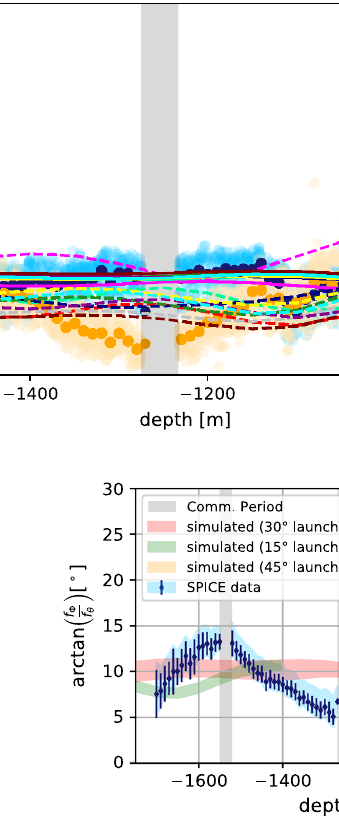
Fig. 12 Measured polarization at the ARIANNA station and the expected polarization after propagating the anechoic chamber pulses through the birefringence model. The adjacent launch angels of 15 and 45 degrees were included for comparison. The gray areas mark com- munication periods during which no data was taken. The SPICE data was averaged over 10m depths, and the 1 σ spread of the distribution is shown with the blue error bars. The light blue shading indicates the systematic uncertainty on the reconstruction stemming from systematic uncertainties in the ARIANNA LPDA orientations (see [27] for